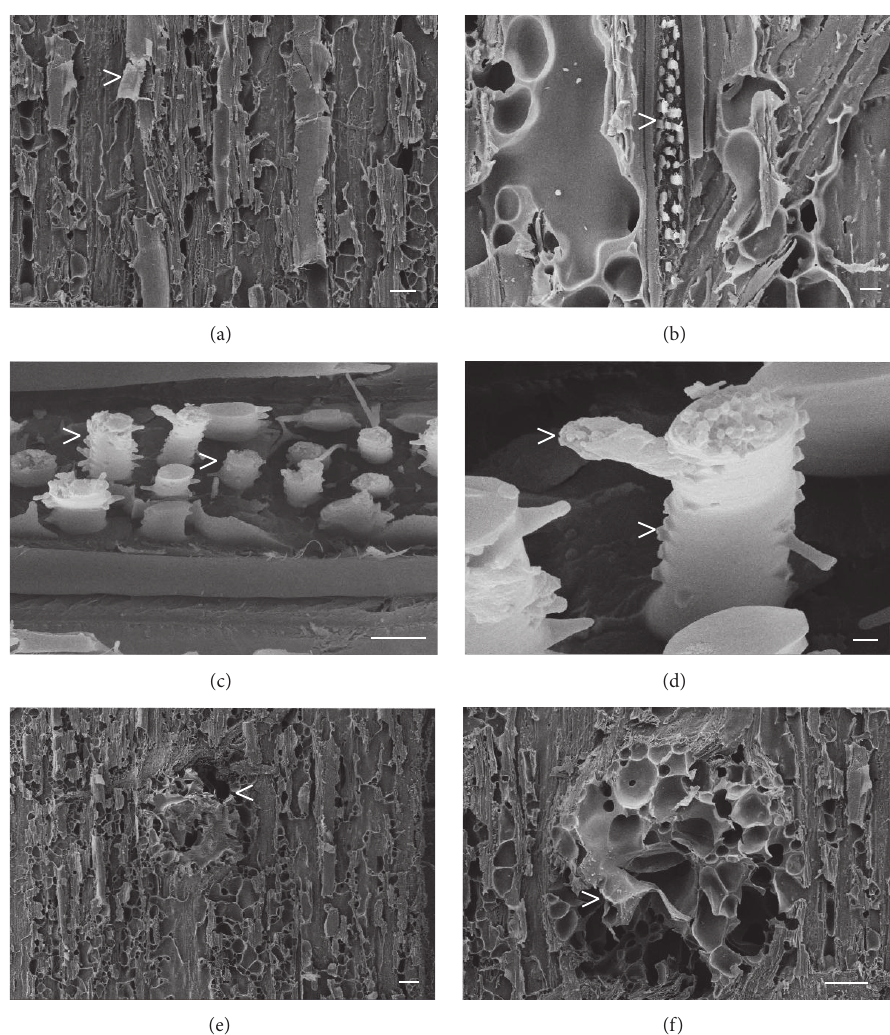
Figure 10: Fracture surfaces of a laminated birch wood composite bonded with unmodified single component polyurethane adhesive; (a) adhesive on fractured wood surface showing pull-out and microfracture of adhesive that partially covers the wood surface (arrowed left; scale bar = 100 𝜇 m); (b) fractured wood surface showing a multiseriate ray (centre) and pull-out of adhesive from the lumens of individual ray cells (arrowed centre; scale bar = 20 𝜇 m); (c, d) higher magnification photographs showing the pillars of adhesive that pulled out of ray cells shown in (b). Note the fractured ends of the pillars and the intact and fractured side-arms (branches) (arrowed left and centre; scale bars = 10 𝜇 m (c) and 1 𝜇 m (d)); (e) fractured column of adhesive that provided through-reinforcement to the composite (arrowed centre) and residual adhesive on the fractured wood surface (scale bar = 200 𝜇 m); (f) higher magnification photograph of the adhesive column shown in (e). Note the fracture and distortion of the adhesive column and the distortion of the adjacent wood (arrowed; scale bar = 200 𝜇